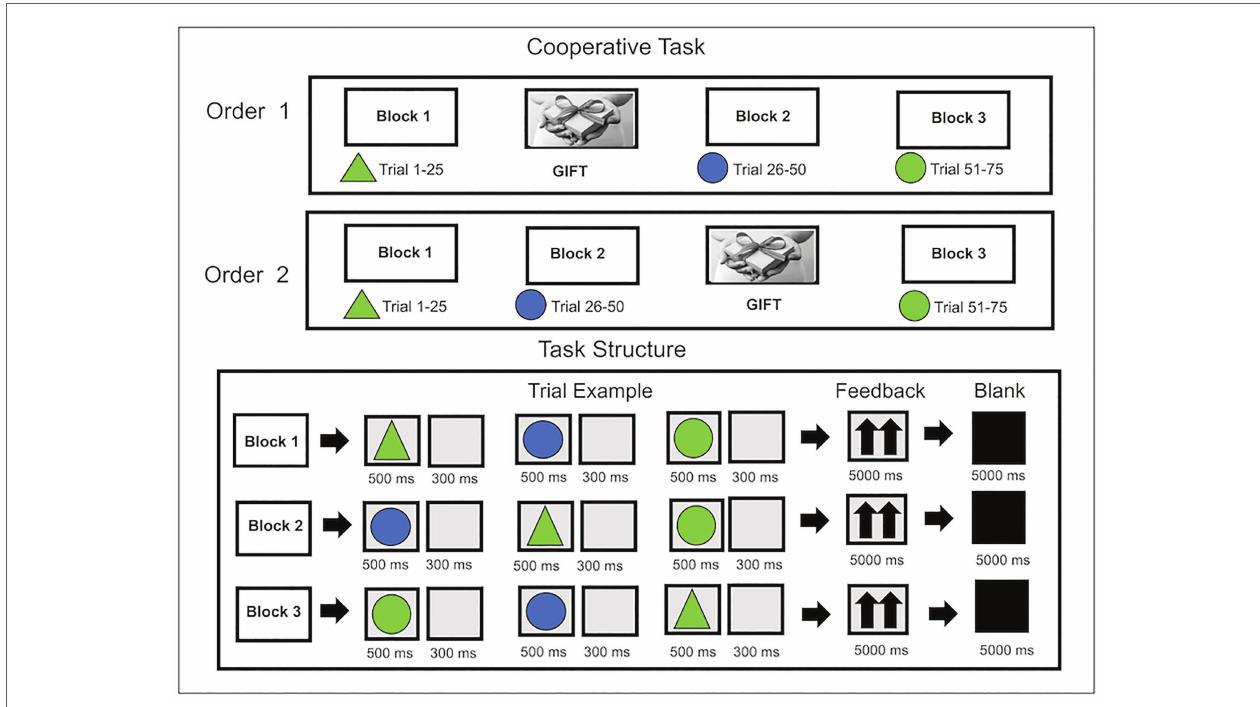
FIGURE 1 | Experimental procedure. Two different procedures were performed: order 1 composed by block 1 (a control condition), gift exchange, and blocks 2 and 3; and order 2 composed by block 1, block 2, gift exchange, and block 3. Blocks 1, 2, and 3 involve a cooperative task which consisted of a game of selective